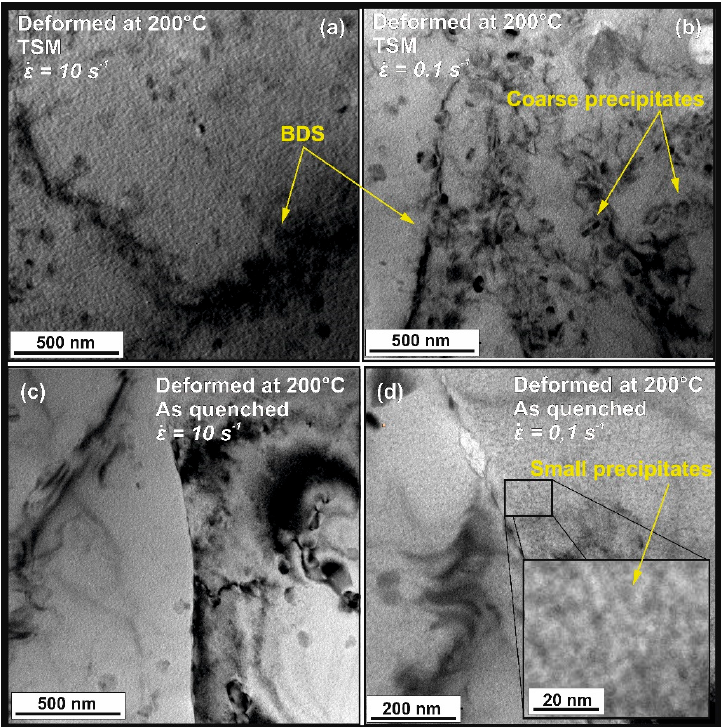
Figure 7. TEM ‐ micrograph of TSM condition deformed at 𝑇 (cid:3005)(cid:3021) (cid:3404) 200 °C and strain rates of ( a ) 𝜀(cid:4662) (cid:3404) Figure 7. TEM- micrograph of TSM condition deformed at T DT = 200 ◦ C and strain rates of 10 s (cid:2879)(cid:2869) and ( b ) strain rates of 𝜀(cid:4662) (cid:3404) 0.1 s (cid:2879)(cid:2869) . TEM ‐ micrograph of as ‐ quench condition deformed at . . 𝑇 (cid:3005)(cid:3021) (cid:3404) 200 °C and strain rates of ( c ) 𝜀(cid:4662) (cid:3404) 10 s (cid:2879)(cid:2869) and ( d ) strain rates of 𝜀(cid:4662) (cid:3404) 0.1 s (cid:2879)(cid:2869) . ε = 10 s − 1 and ( b ) strain rates of ε = 0.1 s − 1 . TEM- micrograph of as-quench condition deformed ( a ) . . ε = 10 s − 1 and ( d ) strain rates of ε = 0.1 s − 1 at T DT = 200 ◦ C and strain rates of ( c ) Figure 8 shows the deformed microstructure of the as ‐ quenched condition at the de ‐ formation temperature of 𝑇 (cid:3005)(cid:3021) (cid:3404) 200 °C and strain rate of 𝜀(cid:4662) (cid:3404) 0.1 s (cid:2879)(cid:2869) for better visualiza ‐ tion of the precipitate distribution. From this figure, fine and homogenously distributed precipitates can be seen. Moreover, coarse precipitates are also observed for this condition due to the used deformation temperature. Hence, this condition exhibits a mixed micro ‐ structure consisting of predominantly fine and few coarse precipitates.